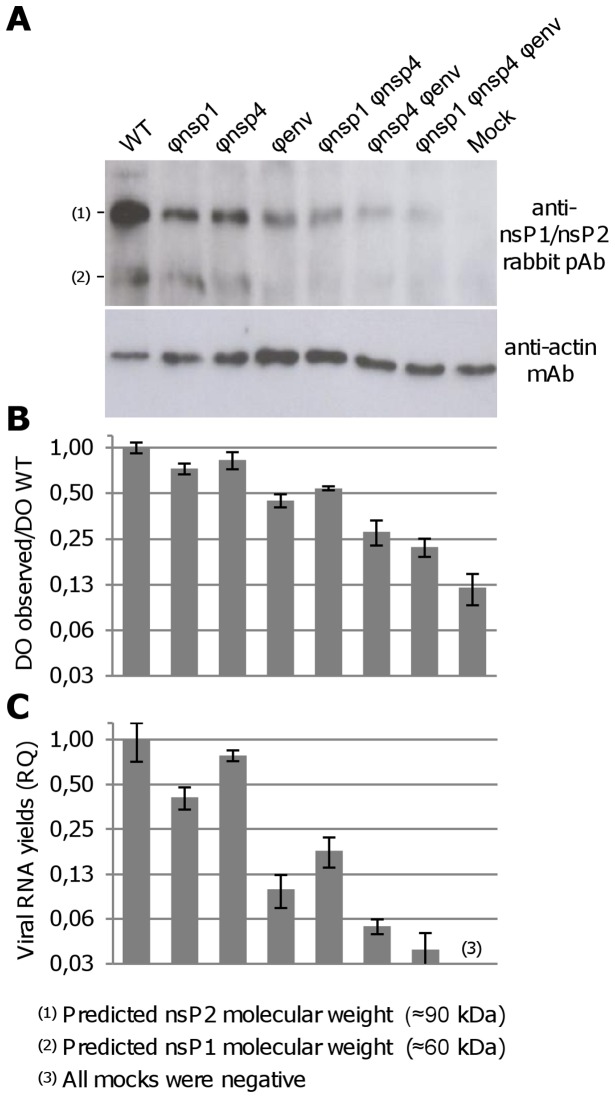
Synthesis of viral proteins and intracellular viral RNA.To study, at the intracellular level, how our codon re-encoding method modified viral RNA and protein synthesis, 12-well-plates of HEK293 cells were infected with virus at an estimated MOI of 5. Cells were washed after the infection and intracellular RNA and proteins were extracted at 8 hours pi simultaneously or individually (cf. materials and methods). Viral protein levels were measured using two methods: a western blot analysis using anti-nsP1/nsP2 rabbit pAb (A) and an ELISA (B) using a CHIKV-specific immune human serum (recognizing especially the structural proteins [32]–[35]). In panel B, results are expressed as percentage of WT and are the mean/standard deviation of three independent experiments. Viral RNA yields were quantified by real time comparative RT-PCR using actin mRNA as a normalizer and cells infected by the WT virus as a calibrator (C); Results are the mean relative quantity (RQ) from three independent experiments and errors bars are RQ max and RQ min values generated by the Stratagene Mx3005P software at 99% confidence level; Results are the mean and standard deviation from three independent experiments.